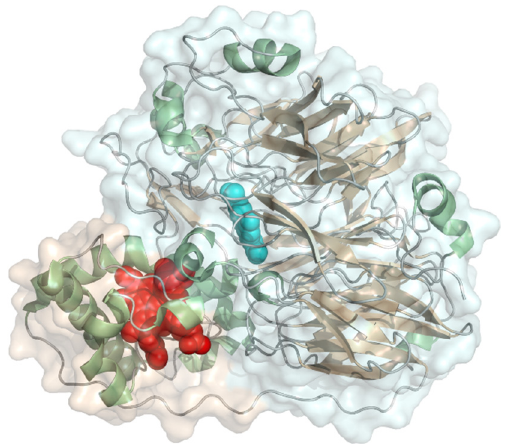
Figure 15. Crystal structure of Pseudomonas putida type II alcohol dehydrogenase (PDB: 1YIQ) com- prising a PQQ-dependent dehydrogenase domain (light cyan) and a heme c-dependent cytochrome domain (light red). The respective cofactors are shown as colored spheres (PQQ, cyan; heme c, red).